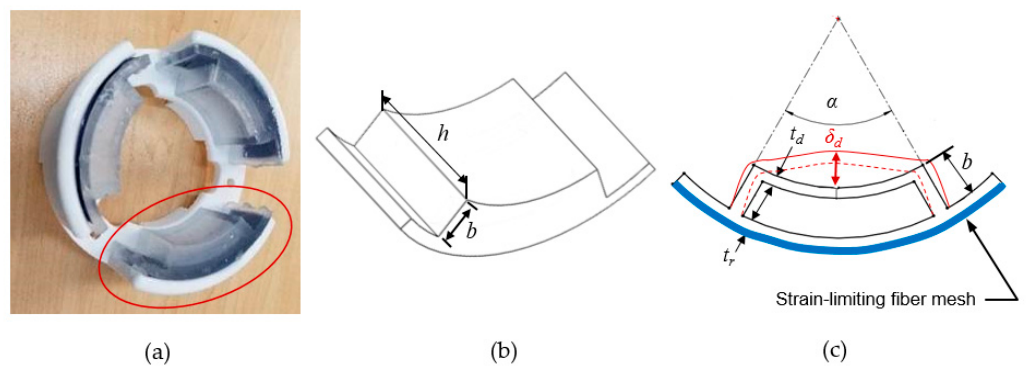
Figure 2. ( a ) Bottom view of a closed ring gripper assembly comprised of three modular pneumatic actuators. ( b ) Outside geometry of the actuator’s pneumatic chamber. ( c ) Internal structure of the chamber walls, location of the strain-limiting fiber mesh (blue), and the impact of inflation ( δ d ) on the active deformable wall (red). Note that the deformation is for visualization purposes only.